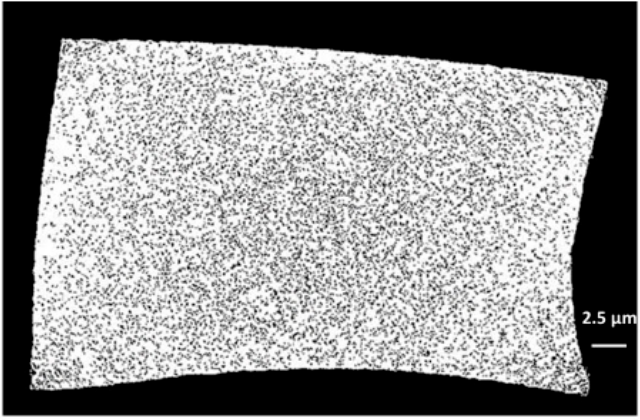
Figure 12. Micro-computed tomography investigation of ZA 22 elastomer.